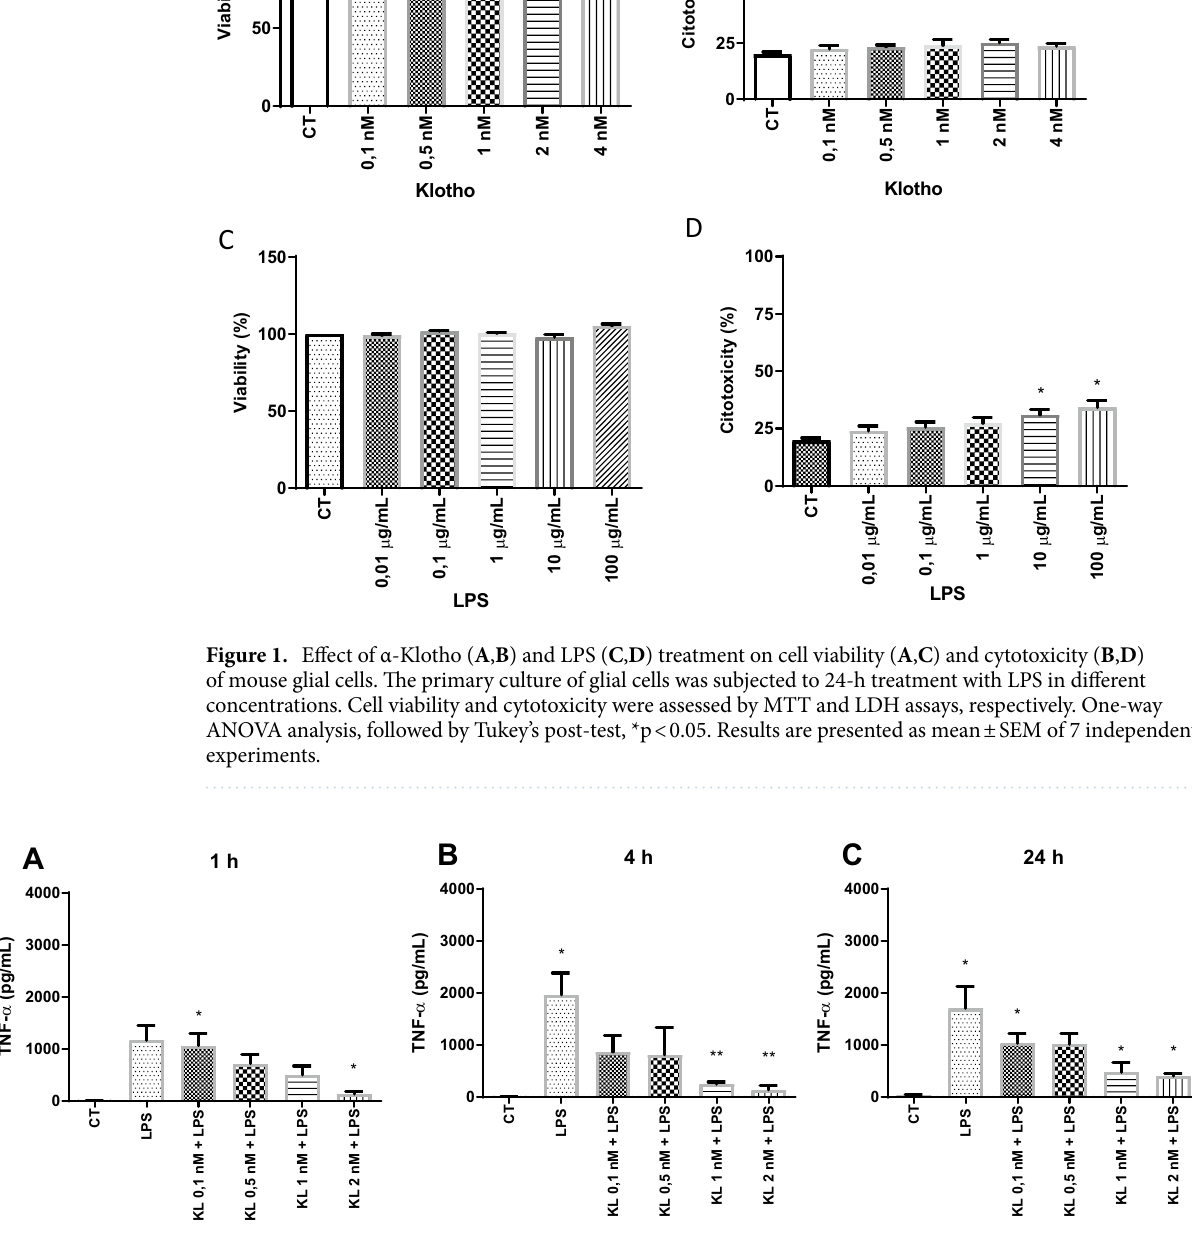
Figure 2. Effect of α-Klotho on LPS-induced TNF-α secretion in mouse glial cells. The glial culture was pre- treated with serum-free medium (control) or with α-Klotho protein in different concentrations (0.1, 0.5, 1, and 2 nM) and times 1 ( A ), 4 ( B ), and 24 ( C ) hours, and then challenged with 1 µg/mL/mL LPS for 8 h. The supernatant was collected to measure TNF-α levels. One-way ANOVA analysis, followed by Tukey’s post-test, *p < 0.05, **p < 0.01. Results are presented as mean ± SEM of 7 independent